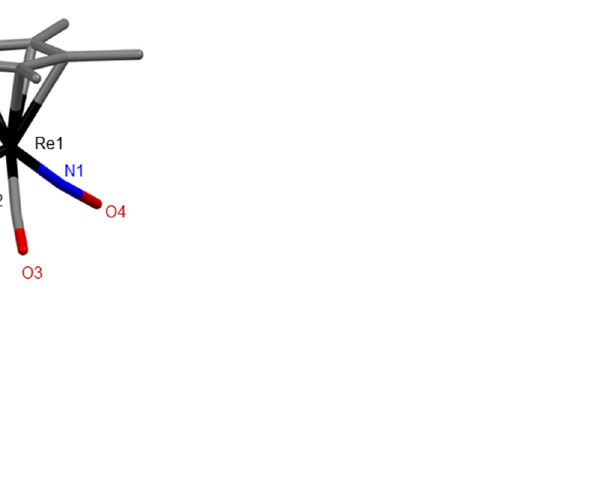
Figure 22. Molecular structure of 19 , adapted from [76] (MERCURY view). Hydrogen atoms are omitted for clarity (Sn light blue, O red, P orange, N blue, Re black, C grey). In 1995, Gibson et al. resolved by X-ray diffraction, the structure of four new CO 2 - bridged transition metals/tin complexes [77]. CpFe(CO)(PPh 3 )(CO 2 SnMe 3 ) ( 20 ) and CpFe(CO)(PPh 3 )(CO 2 Sn( n- Bu) 3 ) ( 21 ) were synthesized by reaction in THF between CpFe(CO)(PPh 3 )CO 2 − K + and ClSnMe 3 and ClSnPh 3 , respectively. In both cases, the bridg- ing carboxyl ligand adopts a μ 2 - η 3 coordination mode in which the carboxyl atom is bound to the iron atom and both oxygens are bound to the tin atom. Cp*Fe(CO) 2 (CO 2 SnPh 3 ) ( 22 ) was prepared from Cp*Fe(CO) 3+ BF 4 − and Ph 3 SnCl in CH 2 Cl 2 at 0 °C in the presence of KOH. Compound 22 displays a similar structure to that of complexes 20 and 21 in which tin atoms are five-coordinated and adopt a distorted trigonal-bipyramidal geometry. The CO 2 -bridged rhenium-tin complex Cp*Re(CO)(NO)(CO 2 SnMe 3 ) ( 23 ) was isolated as crystalline solid from Cp*Re(CO)(NO)COOH and ClSnMe 3 in the presence of KOH. The X-ray structure of 23 highlighted a μ 2 - η 2 coordination mode of the bridging CO 2 ligand in which the carbonyl carbon and one oxygen atom are bonded to the rhenium atom and the tin atom, respectively. As a result, the tin atom adopts a distorted tetrahedral geometry (Figure 23).